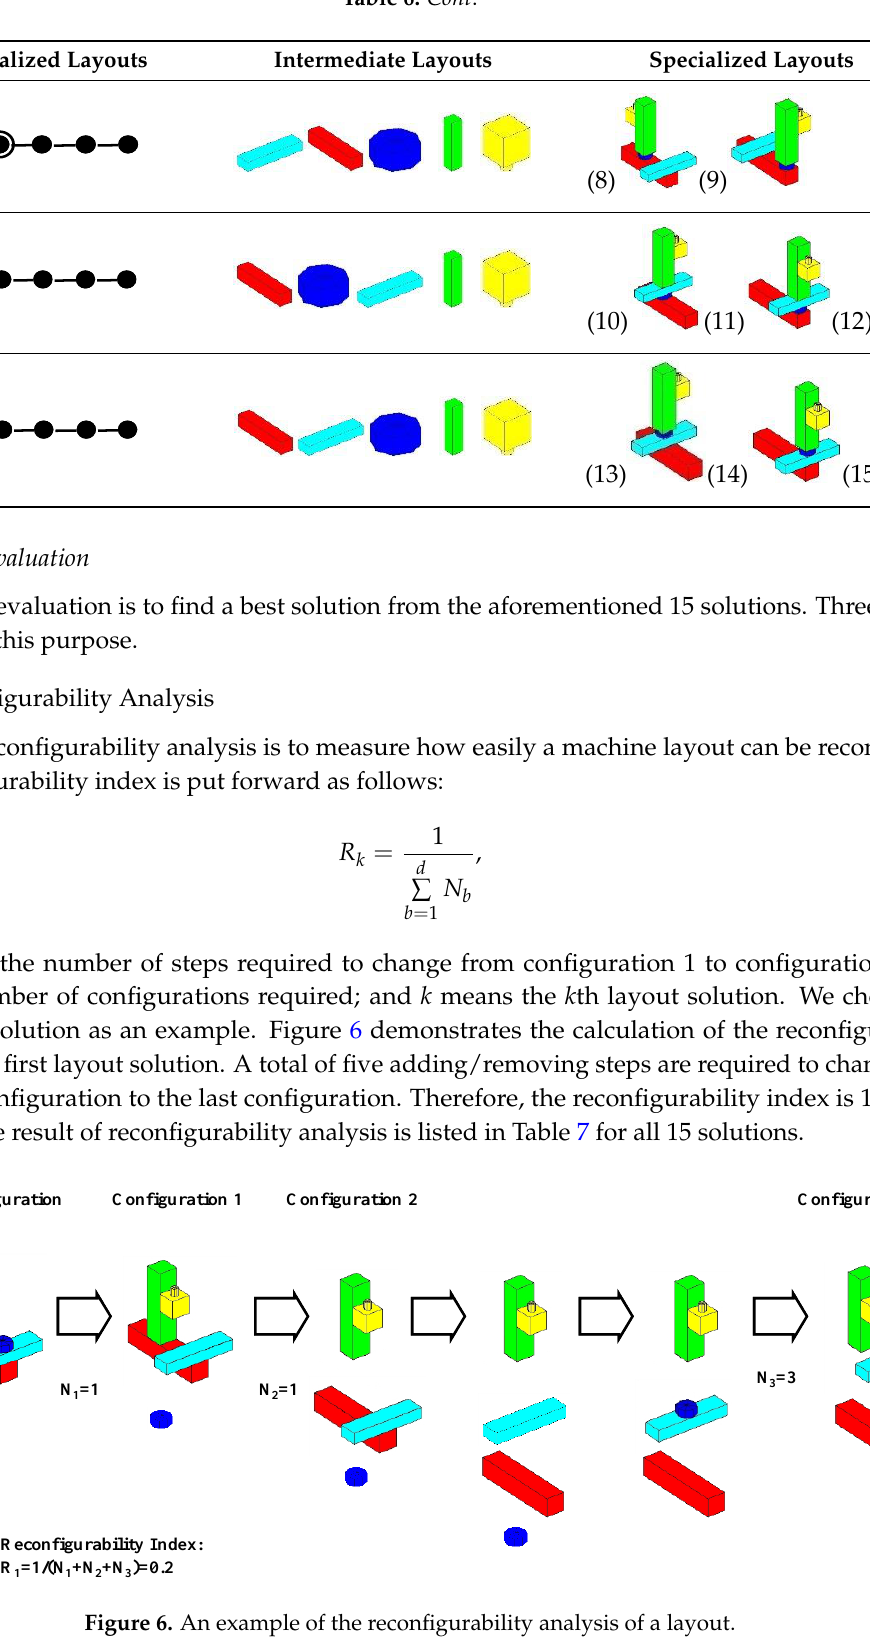
Figure 6. An example of the reconfigurability analysis of a layout.